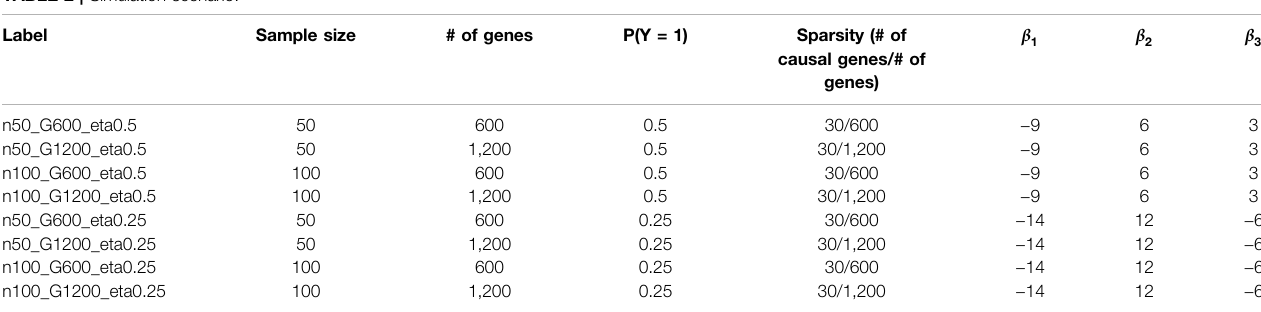
TABLE 2 | Simulation